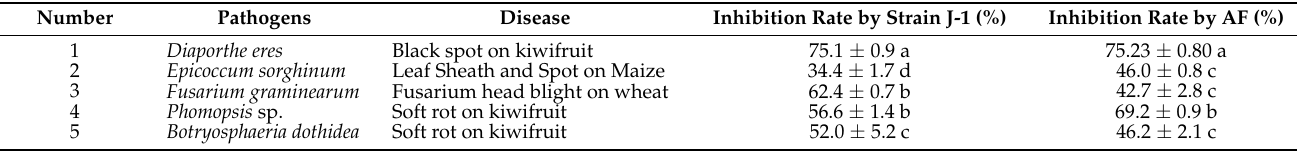
Figure 4. Determination of conidial germination of A. alternata treated with different concentration aseptic filtrates after 12 h. T1 (200 mL L −1 ); T2 (100 mL L −1 ); and T3 (50 mL L −1 ). Control (Sterile water treatment). Table 3. Antifungal spectrum of strain J-1 and its aseptic filtrate.